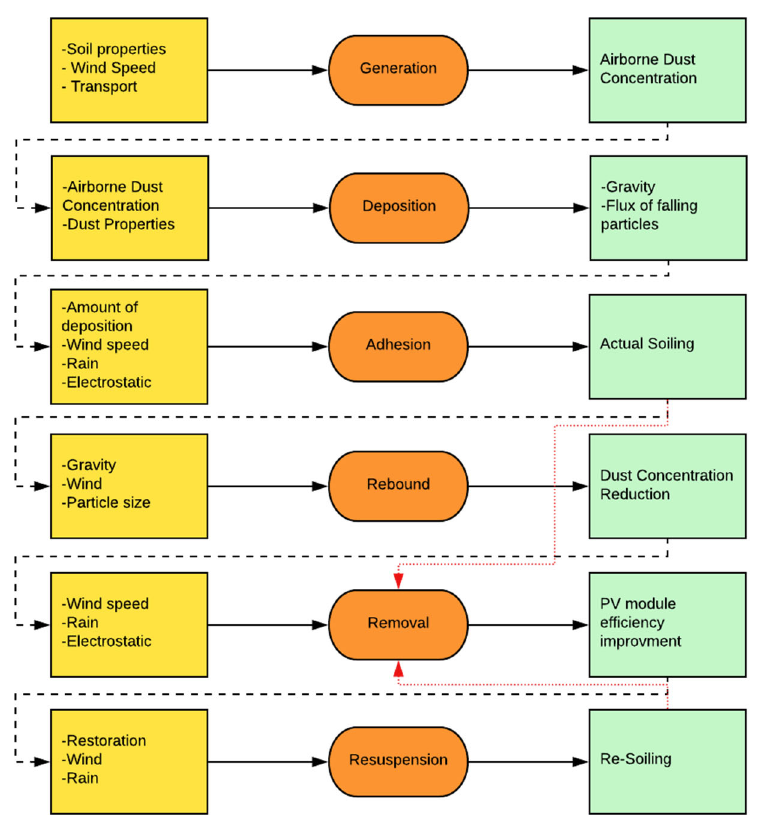
Figure 4. Dust accumulation life cycle and interrelated